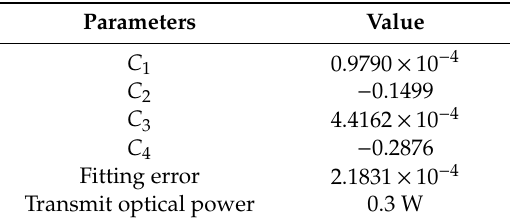
Table 1. Main Simulation